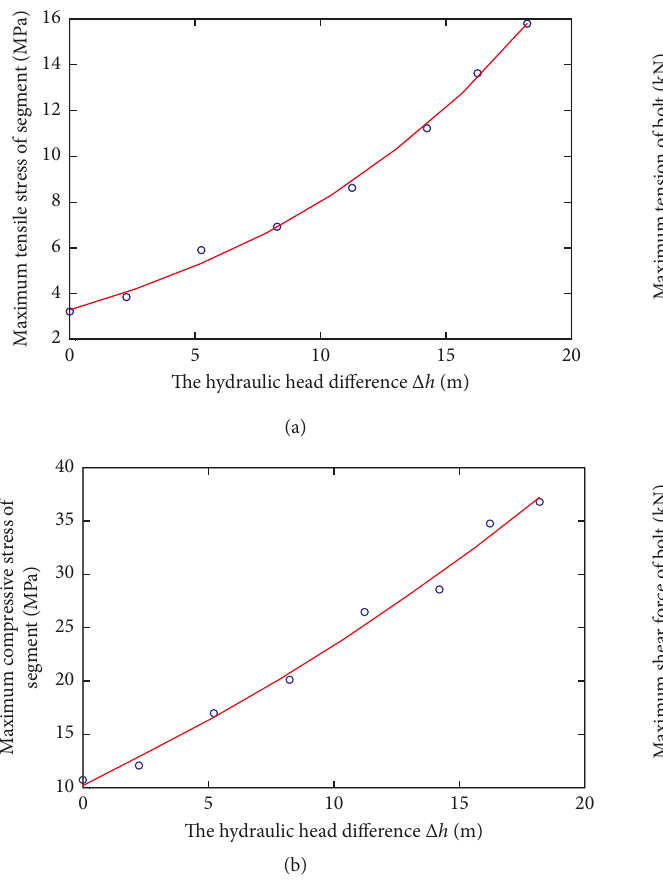
Figure 24: The relationship between the tensile and compressive stress in the concrete constituting segment joints and the water head difference over the excavation face. (a) The maximum tensile stress. (b) The maximum compressive stress.